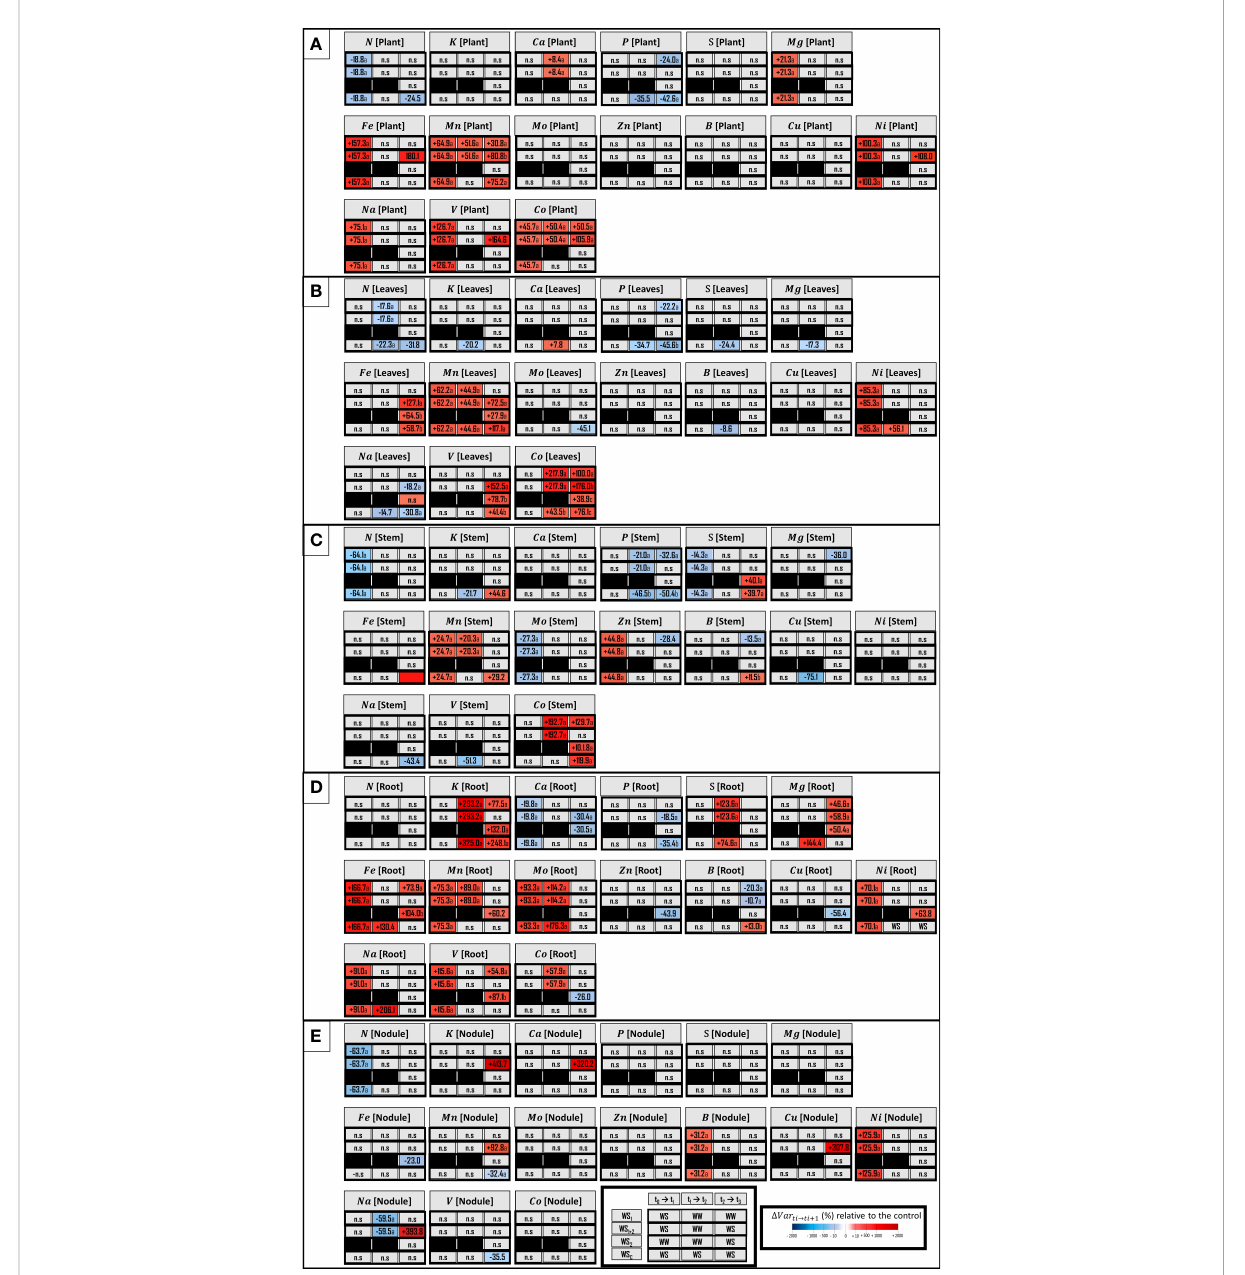
FIGURE 6 Concentrations of macro-nutrients, micro-nutrients and three bene fi cial elements in whole plant (A) and leaves (B) , stem (C) , roots (D) , nodules (E) . Elements (E) characterized are N, nitrogen; K, potassium; Ca, calcium; P, phosphorus; S, sulfur; Mg, magnesium; Fe, iron; Mn, manganese; Mo, molybdenum; Zn, zinc; B, boron; Cu, copper; Ni, nickel; Na, sodium; V, vanadium, and Co, cobalt. The effect of each treatment (WS 1 , transient vegetative stress; WS 1+2 , recurrent stresses; WS 2 , transient reproductive stress; WS c , continuous stress) was expressed relatively to control plants (WW c ) at each harvest (t 1 , t 2 , t 3; n=4 or 5) ( D Var t i ! t i+1 ). Boxes were colored in red when the treatment induced an increase of the variable, and in blue when the treatment induced a decrease of the variable; the intensity of the effect was characterized by the scale of color and the value (percent compared with WW c ) present in the box. Primary data are available in Supplementary Table S3. Letters regroup treatment with non-signi fi cant difference for each